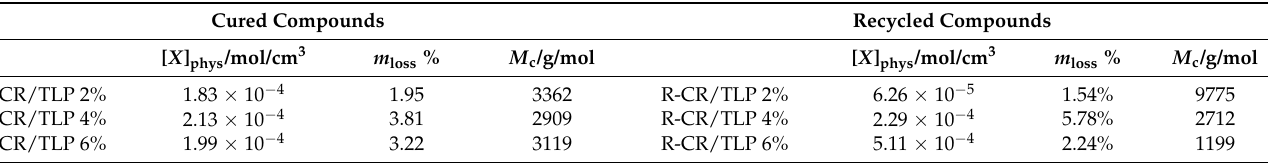
Table 7. Cross-link density, mass loss percentage during swelling experiment and chain mass between cross-links.